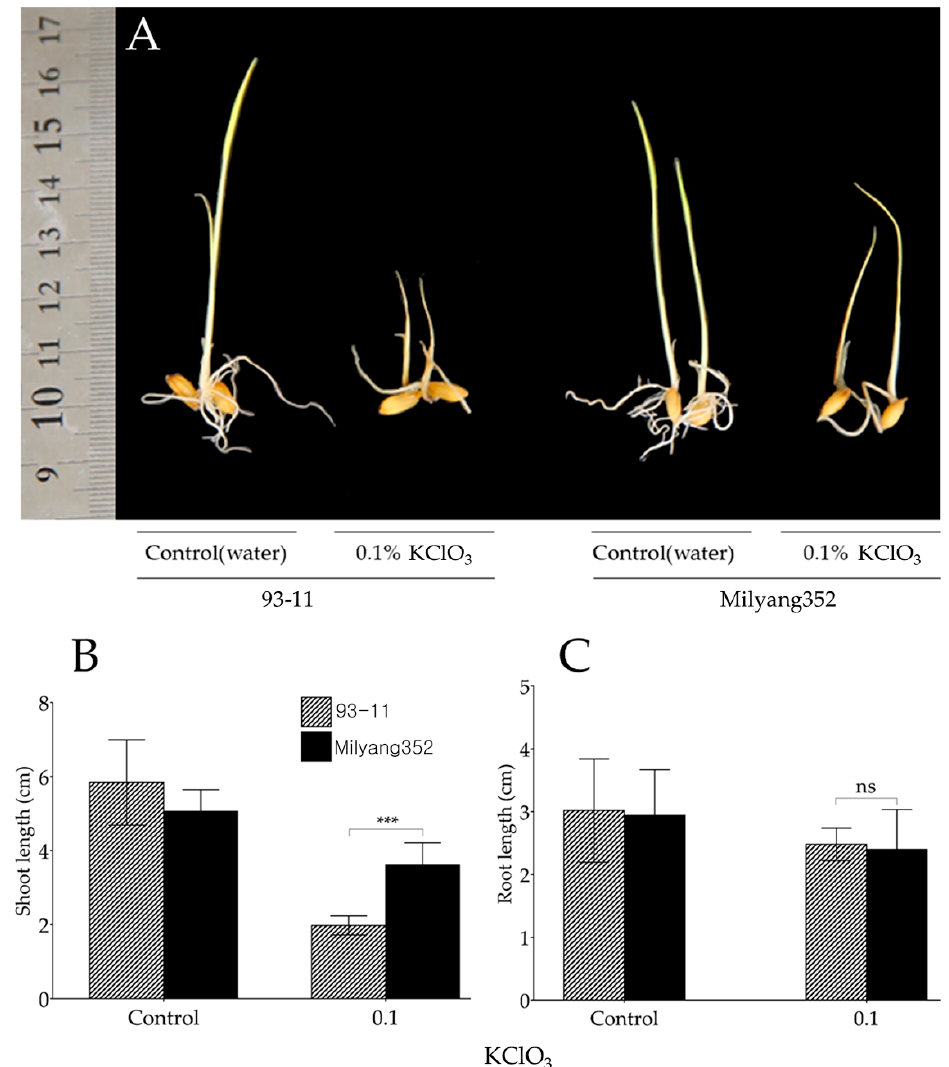
Figure 3. Distinctive phenotypic response of 93-11 ( indica , P1) and Milyang352 ( japonica , P2) toward potassium chlorate (KClO 3 ). ( A ) Phenotype of parental lines used for the development of doubled haploid lines under 0.1% KClO 3 treatment. Picture was captured 7 days after KClO 3 treatment by irrigation. The background of the picture was removed for clear visualization using Adobe Photoshop (Version: 13.0.1., Adobe Inc., San Jose, CA, USA) ( B , C ) Shoot and root growth pattern of 93-11 compared to Milyang352. *** p < 0.001, and ns, non-significant.